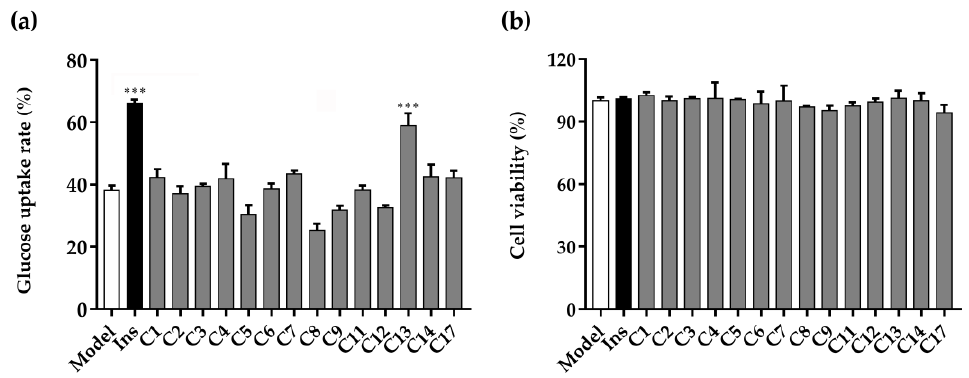
Figure 5. Glucose uptake and cell viability in 3T3-L1 adipocytes. ( a ) Glucose uptake rate of com- pounds 1 − 9 , 11 − 14 , and 17 . ( b ) Cell viability of compounds 1 − 9 , 11 − 14 , and 17 . Ins, insulin (positive control); C, compound; compounds at 20 µ M and insulin at 250 ng/mL; all values are mean ± SD from a least three independent experiments, and each group is compared with model group, significance is denoted by symbols: *** p < 0.001.